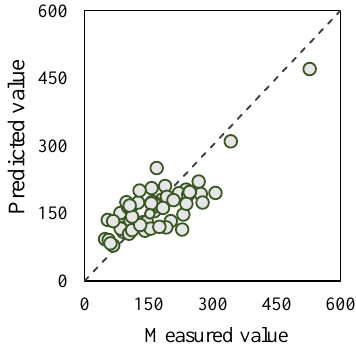
Figure 2. Scatterplots of the predicted versus measured values of pasture biomass (g.m -2 ) in the validation